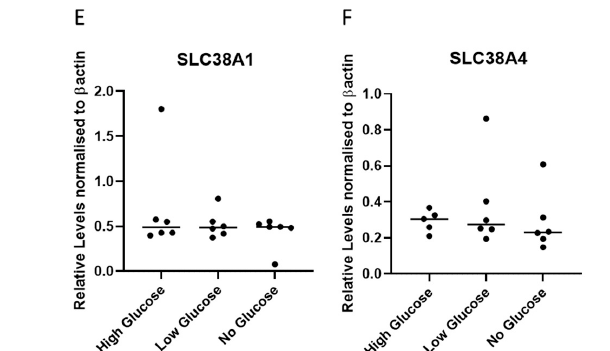
Figure 3. Glucose deprivation significantly upregulated transporter expression in vitro tropho- blast cultures. Compared to normal media controls, glucose deprived cultures significantly upregulated SLC38A1 ( A ), SLC38A2 ( B ), and SLC38A4 ( C ) expression (n = 6/condition). Additionally, in western blots ( D ), the expressions of SLC38A1 ( E ) and SLC38A4 ( F ) were not significantly altered (n = 6/condition). Results are displayed as medians. * p < 0.05, ** p < 0.01, **** p < 0.0001 (repeated measures are for one-way ANOVA for qPCR analysis and for Western blot analysis). On average, hypoxic conditions (1% O 2 ) tended to reduce SLC38A1 (Figure 4A) and SLC38A2 (Figure 4B) expression while significantly promoting SLC38A4 expression (Figure 4C) ( p < 0.05). Western blots (Figure 4D) showed similar expression of transporters between cells incubated under hypoxia and normoxia (8% O 2 ) conditions in the 48-h experimental period (Figure 4E,F).